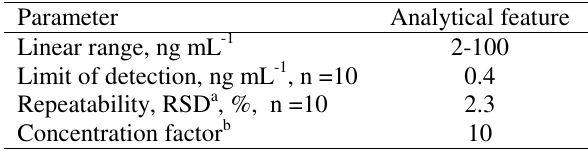
Table 1. Analytical characteristics of proposed